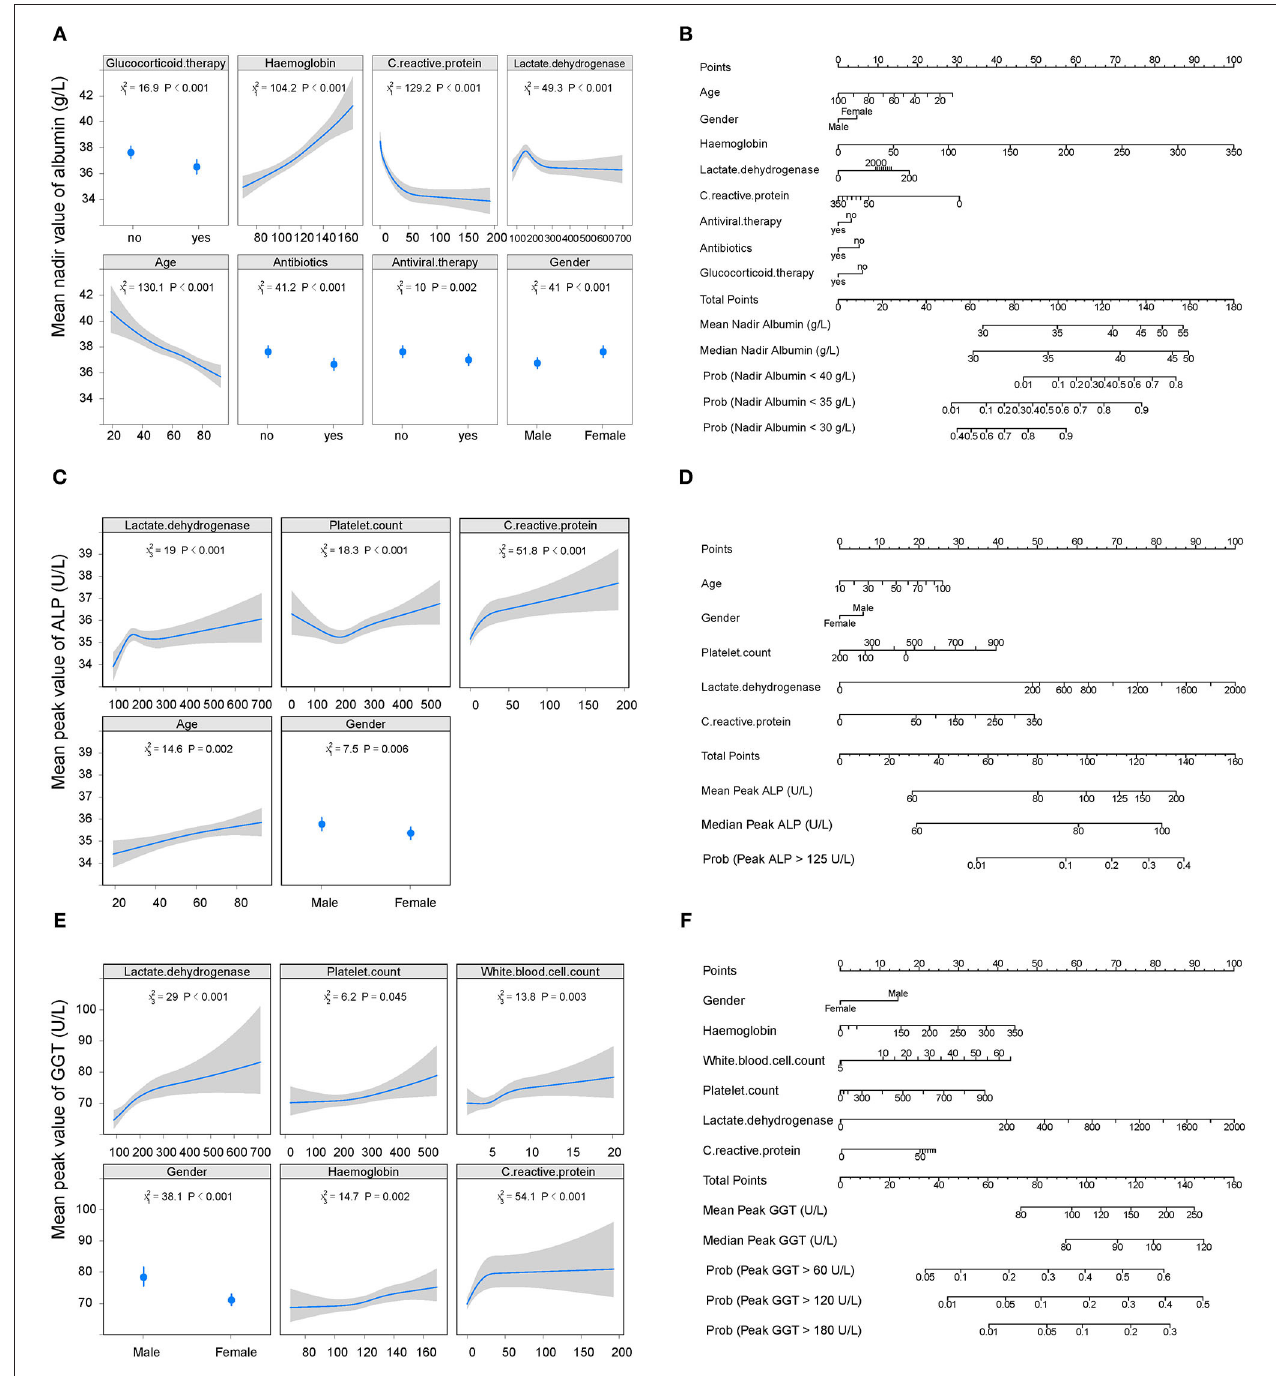
FIGURE 4 | Factors and nomogram for predicting the nadir albumin and peak ALP, GGT during hospitalization. (A, C, E) Multivariable analysis of factors associated with nadir albumin and peak ALP, GGT during hospitalization. The non-linearity of continuous variables were considered and analyzed with restricted cubic splines. (B, D, F) Nomogram for predicting the peak values of nadir albumin and peak ALP, GGT during hospitalization. To use the nomogram, first draw a vertical line to the top points row to assign points for each variable; then, add the points from each variable together and drop a vertical line from the total points row to obtain the median, mean values of nadir albumin and peak ALP, GGT during hospitalization as well as the probability of above the 1-, 2-, 3-time upper limit of normal of these parameters. ALP, alkaline phosphatase; GGT, gamma-glutamyltransferase.